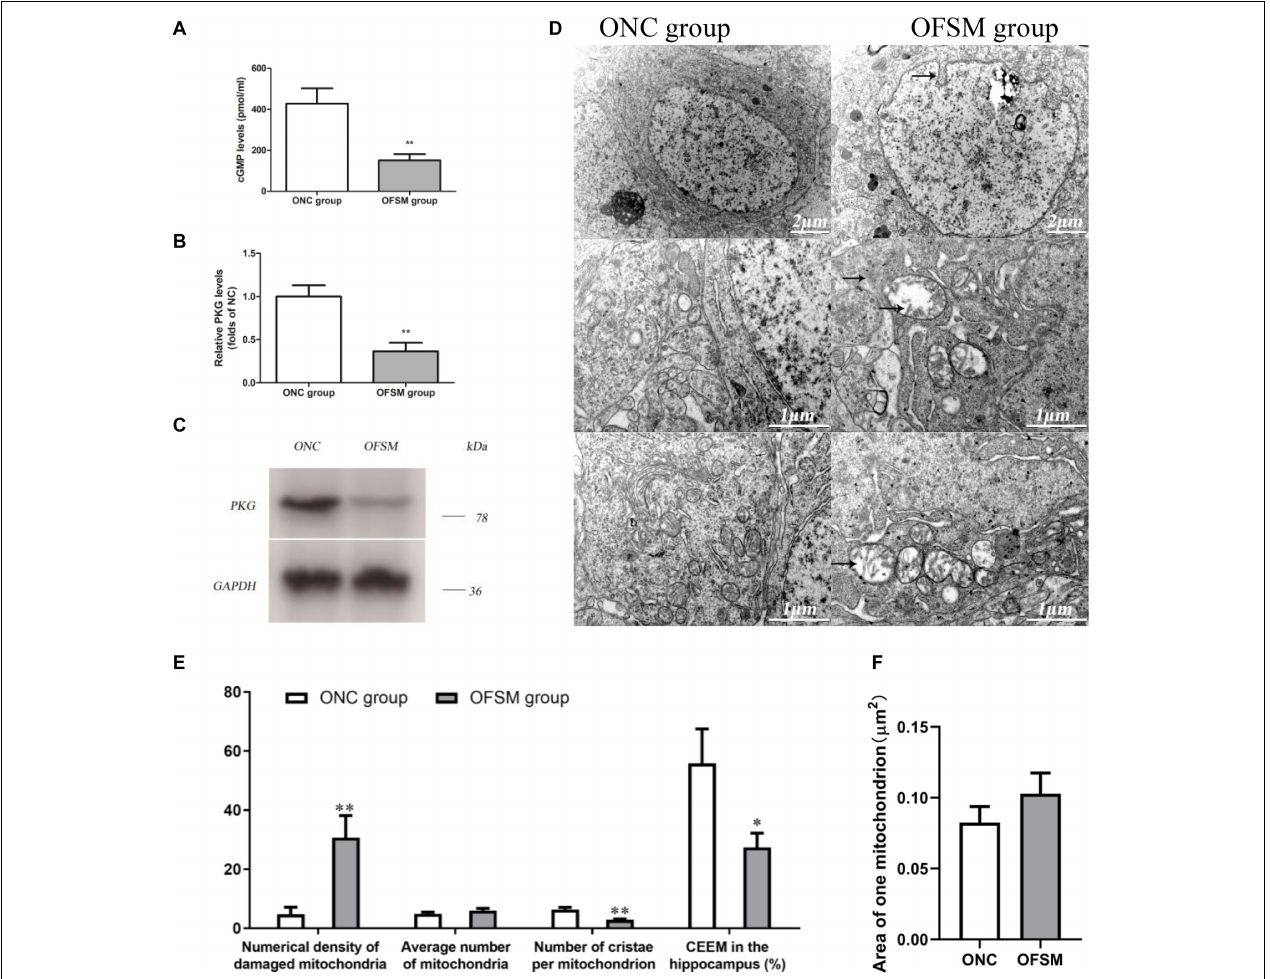
FIGURE 8 | The levels of cyclic guanosine monophosphate (cGMP) and protein kinase G (PKG) expression in the hippocampus of rats were detected by ELISA and western blotting assay, and the ultrastructure of the neurons was observed by electron microscopy. (A) Levels of cGMP. (B) PKG protein expression determined by western blotting. (C) Representative western blotting image of PKG; the results are presented as means ± SD ( n = 6). ** P < 0.01 versus offspring from the normal control group. (D) Representative electron microscopy pictures of hippocampal neurons (the ultrastructural changes are indicated by a black arrow; n = 4 for each group). (E) Morphometric analysis of structural changes in the mitochondria of the hippocampus; the results are presented as means ± SEM. Magnification × 50,000. (F) The percent numerical density of damaged mitochondria in the hippocampus; the results are presented as means ± SEM. Magnification × 50,000. * P < 0.05, ** P < 0.01 versus offspring from the normal control